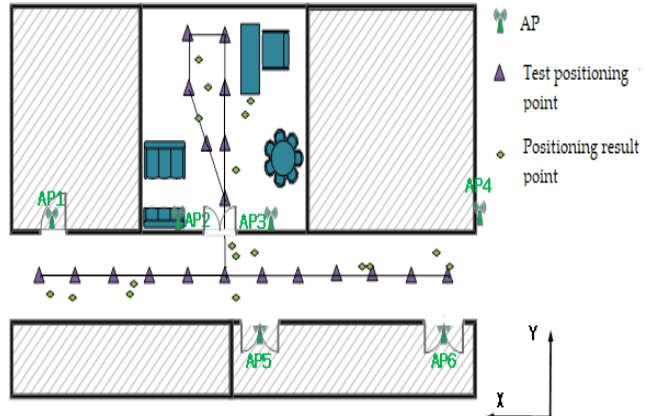
Figure 15. Schematic diagram of track points of test mobile terminal 2 positioning results.